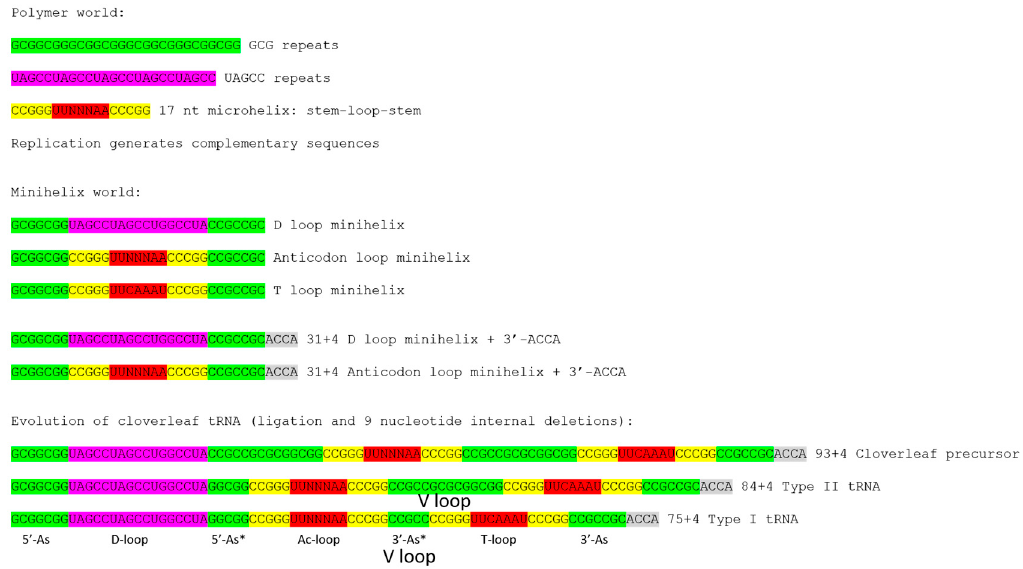
Figure 1. Models for the evolution of type-I and type-II tRNAs. 5 ′ and 3 ′ acceptor stems are shaded green. The D loop 17-nt microhelix is shaded magenta. U-turn stem-loop-stems are shaded yellow (stems) and red (7-nt U-turn loop).